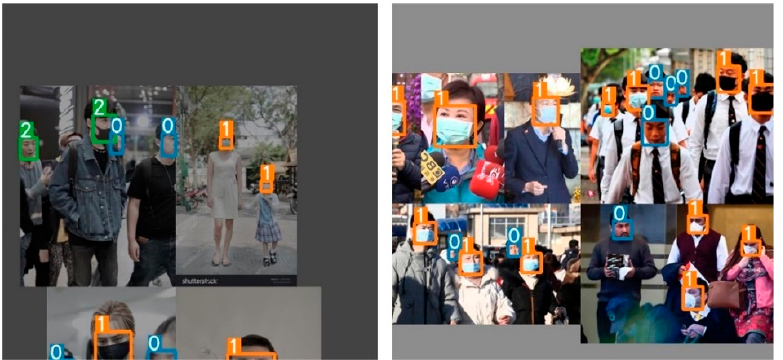
Figure 2. The effect of Mosaic data augmentation.